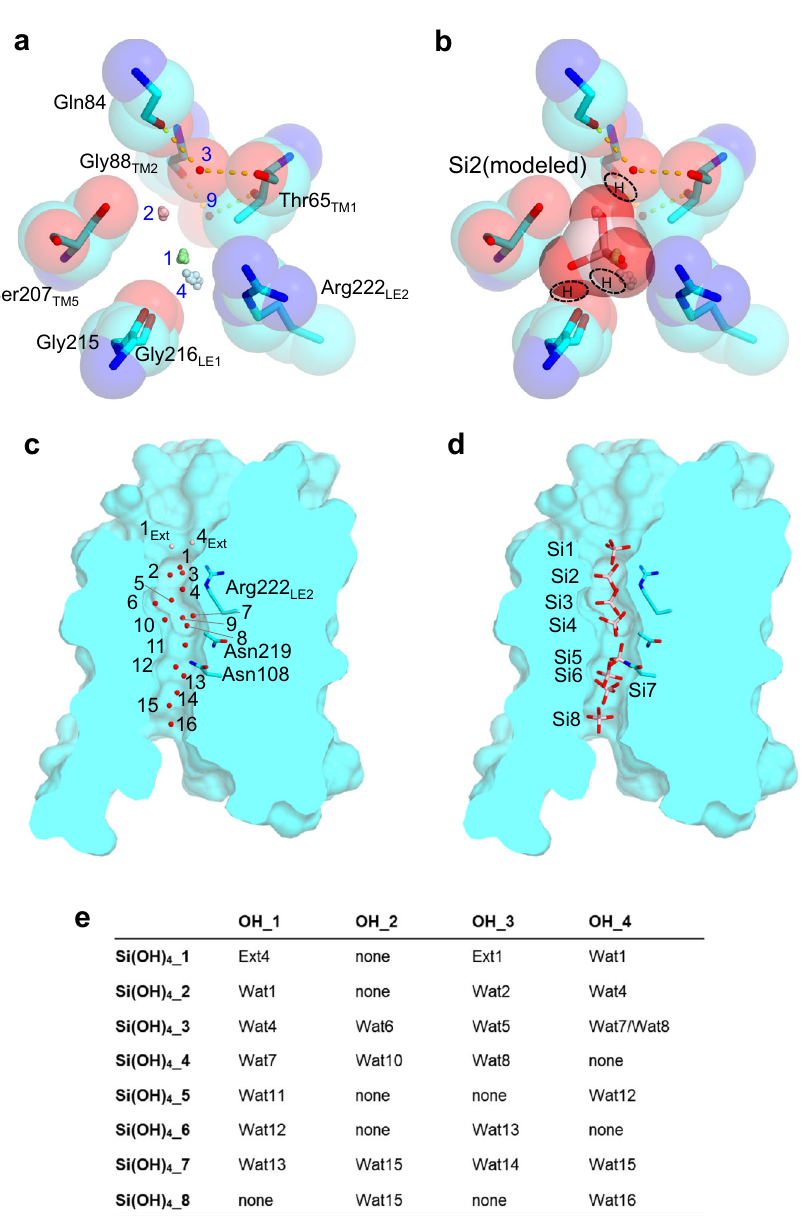
Fig. 6 Structural determinant for the silicic acid permeability and modeled eight silicic acid positions in the Lsi1 channel. SF of Lsi1 cryst ( a ), and a possible conformation of silicic acid during the passage through SF ( b ). Water molecules in the channel (Wat1, Wat2, Wat3, Wat4, and Wat9) are shown as spheres and numbered in blue. Among them, three (Wat1, Wat2, and Wat4) are superposition from the eight Lsi1 cryst protomers of the two tetramers. Putative hydrogens of hydroxyl groups of the silicic acid in the position Si2 are encircled by dashed lines. The view direction is the same as Fig. 2a. Water molecules used for the assignment of possible silicic acid positions ( c ) and the assigned eight silicic acids (Si1-Si8) in the channel ( d ) are shown in a cross- section view. Water molecules in the channel region (red spheres) and the extracellular region (pink spheres) are labeled in numbers. Arg222 LE2 in the SF region and two Asn residues in the NPA motifs are shown as the stick. e Water molecules employed for the assignment of four hydroxyl groups in silicic acid are listed. Ext in c and e indicates water molecules at the extracellular